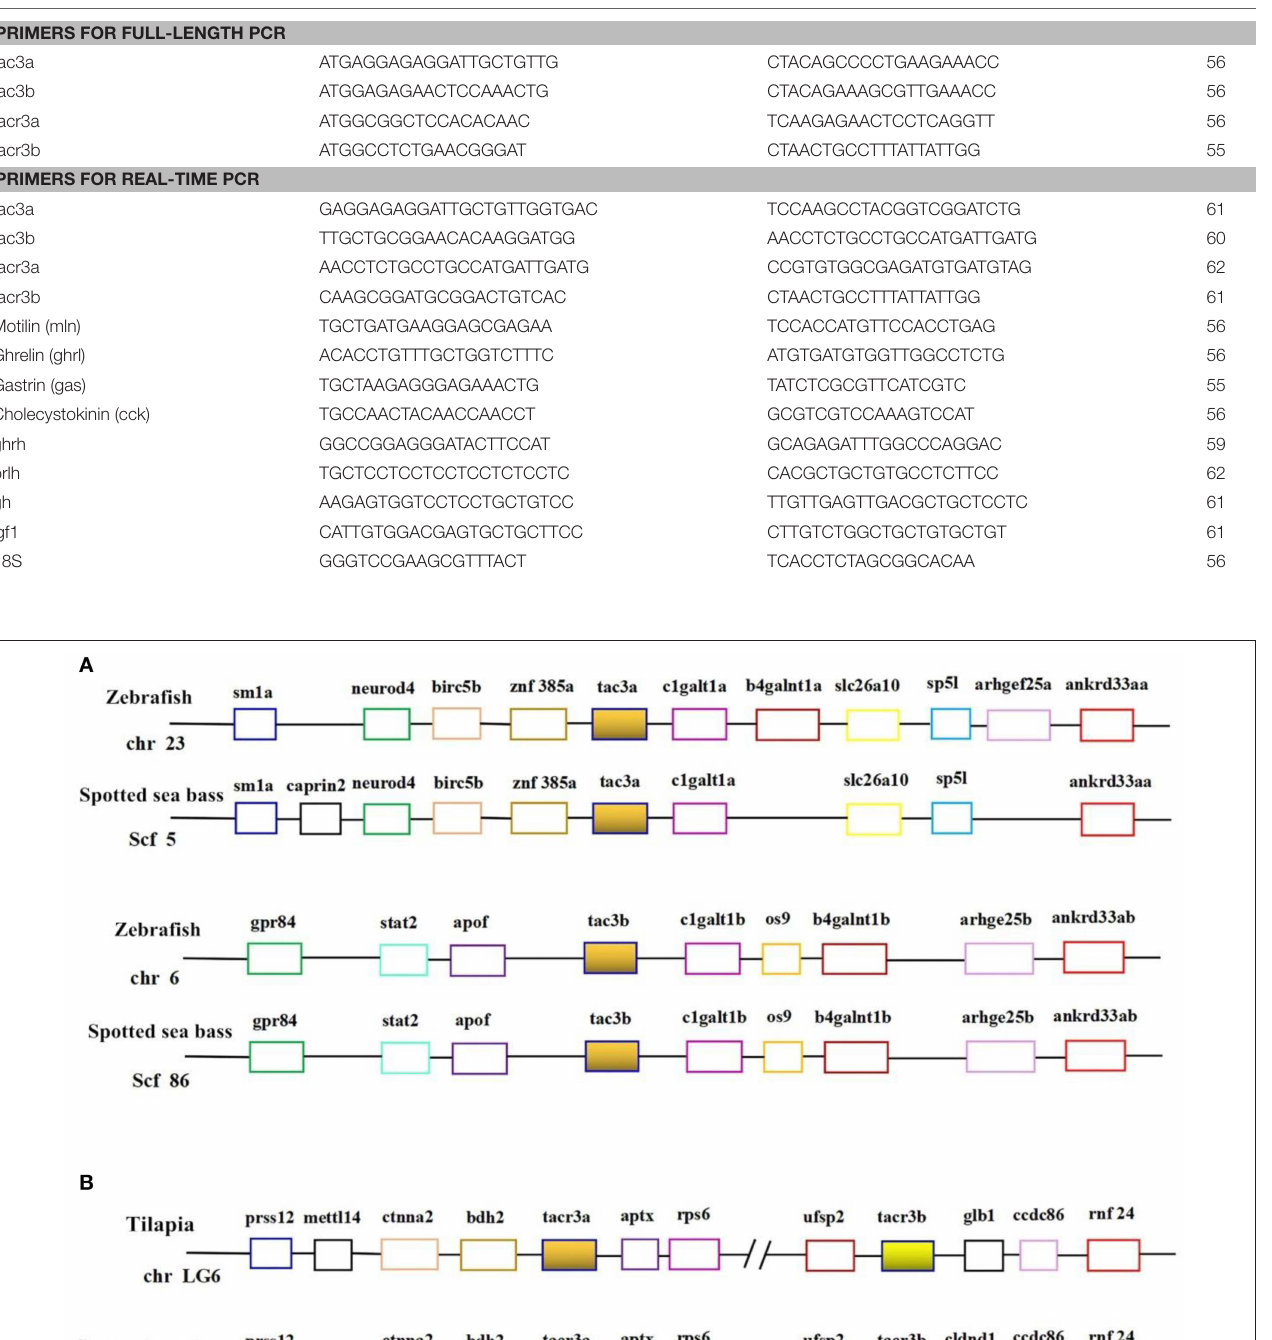
Frontiers in Endocrinology |